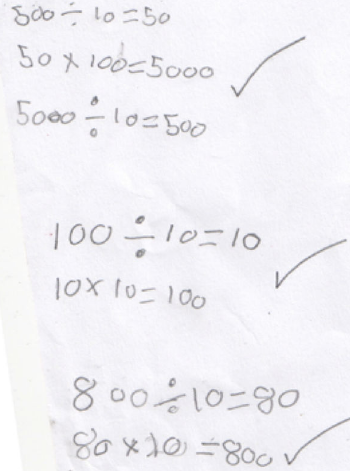
Figure 4. Three ‘journeys’.